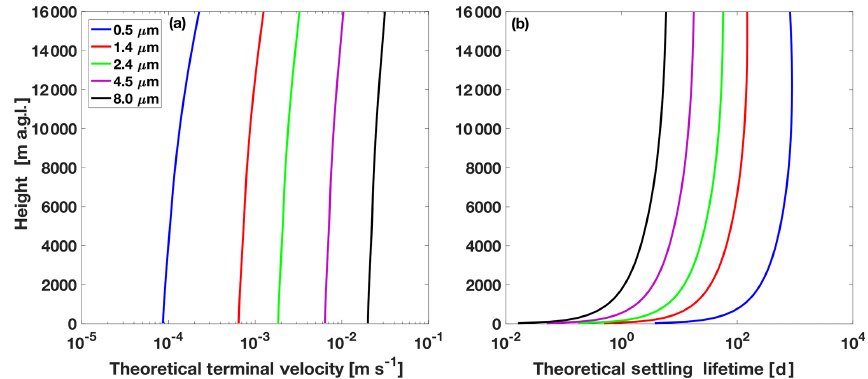
Figure 10. (a) Theoretical terminal velocity of dust particles based on Stokes settling velocity with slip correction for pressure dependence for the five effective radii of dust particles in WRF-Chem. The calculations assume no vertical motion, advection, deposition, coagulation, or condensation. (b) The lifetime of these theoretical dust particles based on their height in the